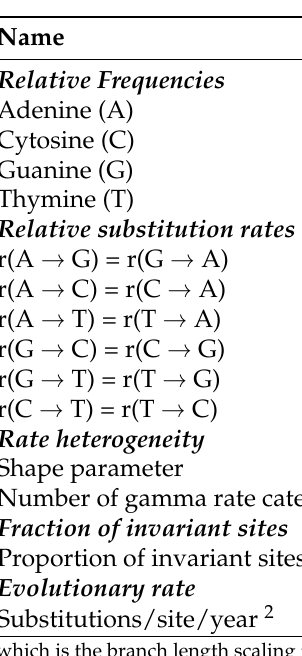
Table A3. Parameters for the HIV 1 substitution GTR + Γ + I